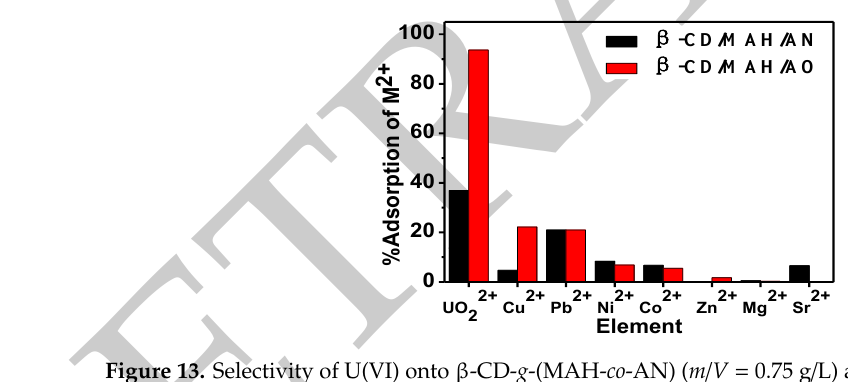
Figure 13. Selectivity of U(VI) onto β -CD- g -(MAH- co -AN) ( m / V = 0.75 g/L) and β -CD- g -(MAH- co -AO) ( m / V = 0.40 g/L). (Conditions: [U(VI)] 0 = 4.1240 × 10 −4 mol/L, I = 0.50 M NaNO 3 , T = 298.15 ± 1.00 K, t = 4 h).